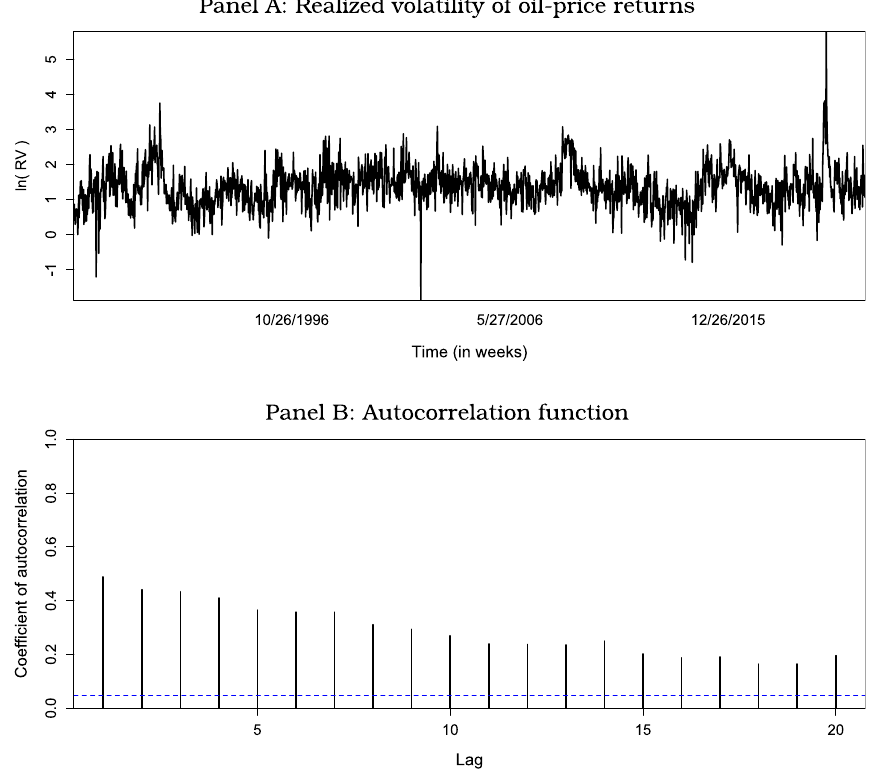
Fig. 1 Properties of the Realized Volatility of Oil-Price Returns. Note: The dashed vertical line in Panel B denotes the 95% significance